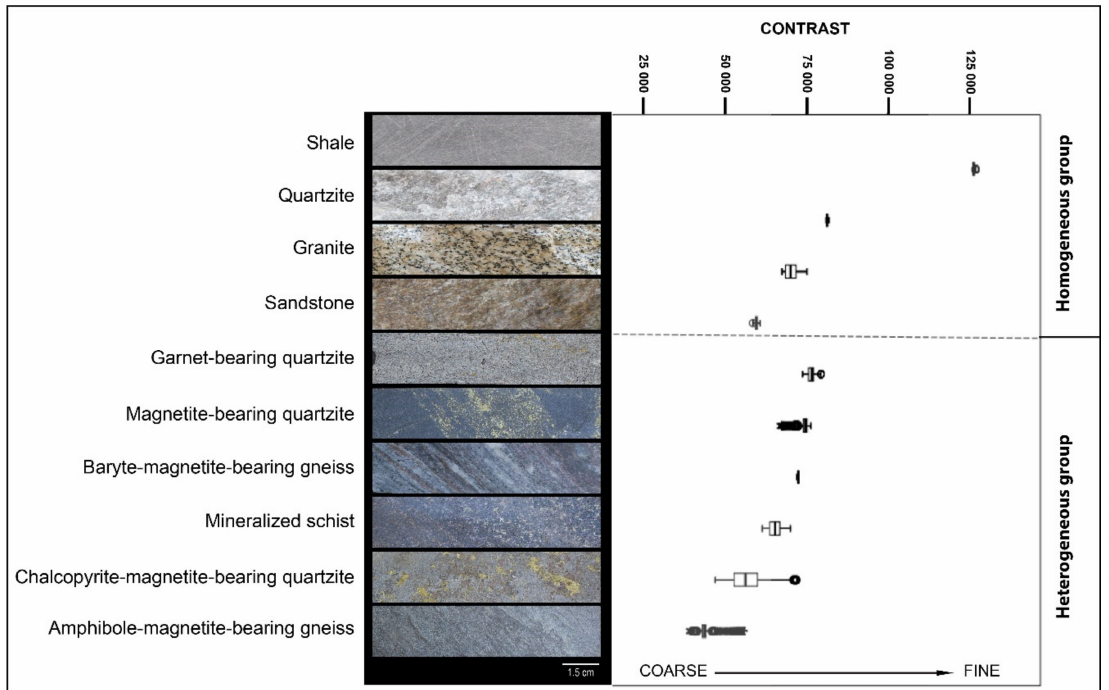
Figure 10. The GLCM contrast statistical descriptor illustrated as box-and-whisker plots for the di ff erent “mineral texture” types using the three-point (air, copper and tungsten) calibration. A thousand images were used for each of the samples. Drill core photographs of the di ff erent mineral texture types are shown to illustrate textural variation ranging in coarse- to fine-grained rocks. The statistical range captured illustrate the degree of mineralogical complexity within each mineral texture